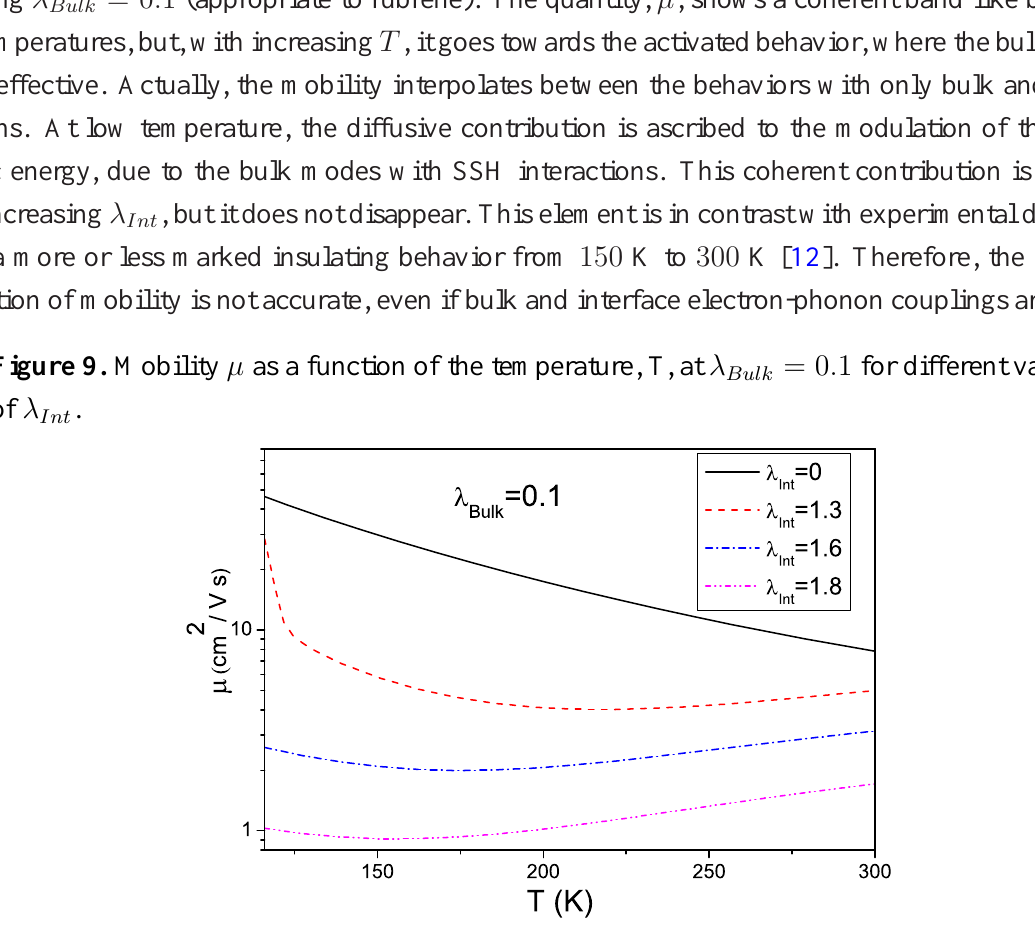
= 0 . 1 for different values Bulk